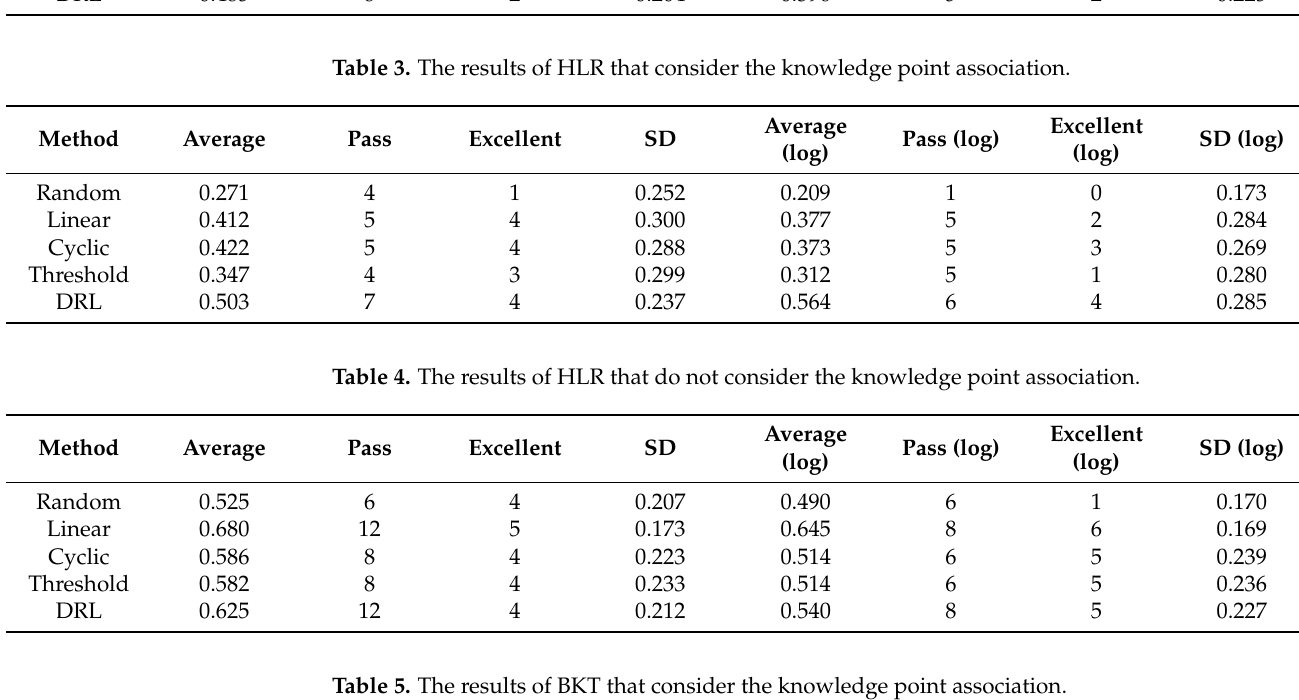
Table 5. The results of BKT that consider the knowledge point